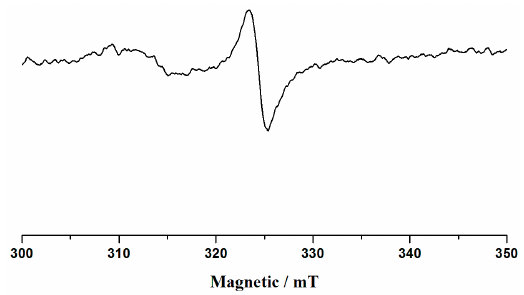
Figure 3. The ESR spectrum of the violet crystal 1 .